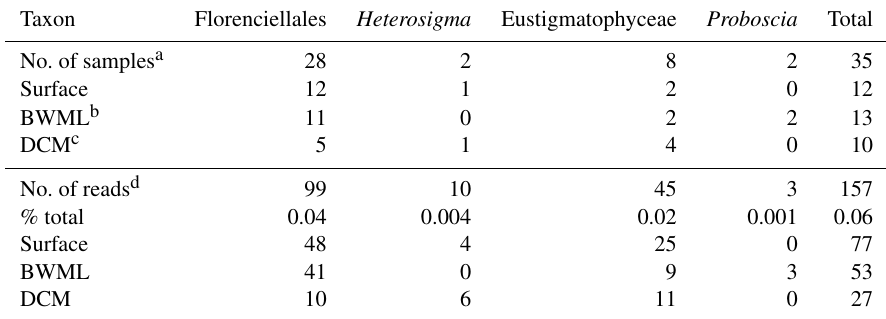
Table 1. Distribution of the 18S rRNA gene reads associated with known LCD producers. Taxon